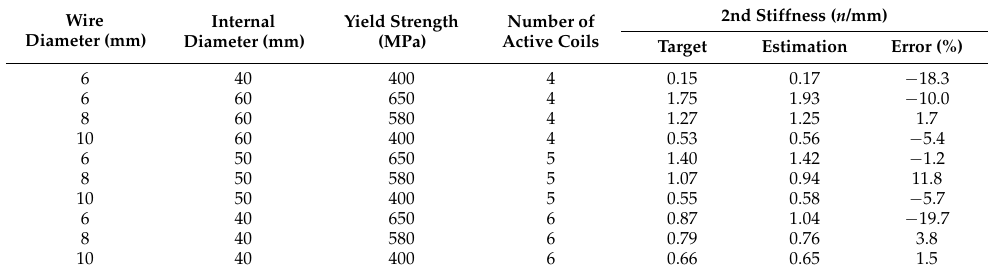
Table 7. Estimated results of ANN3.